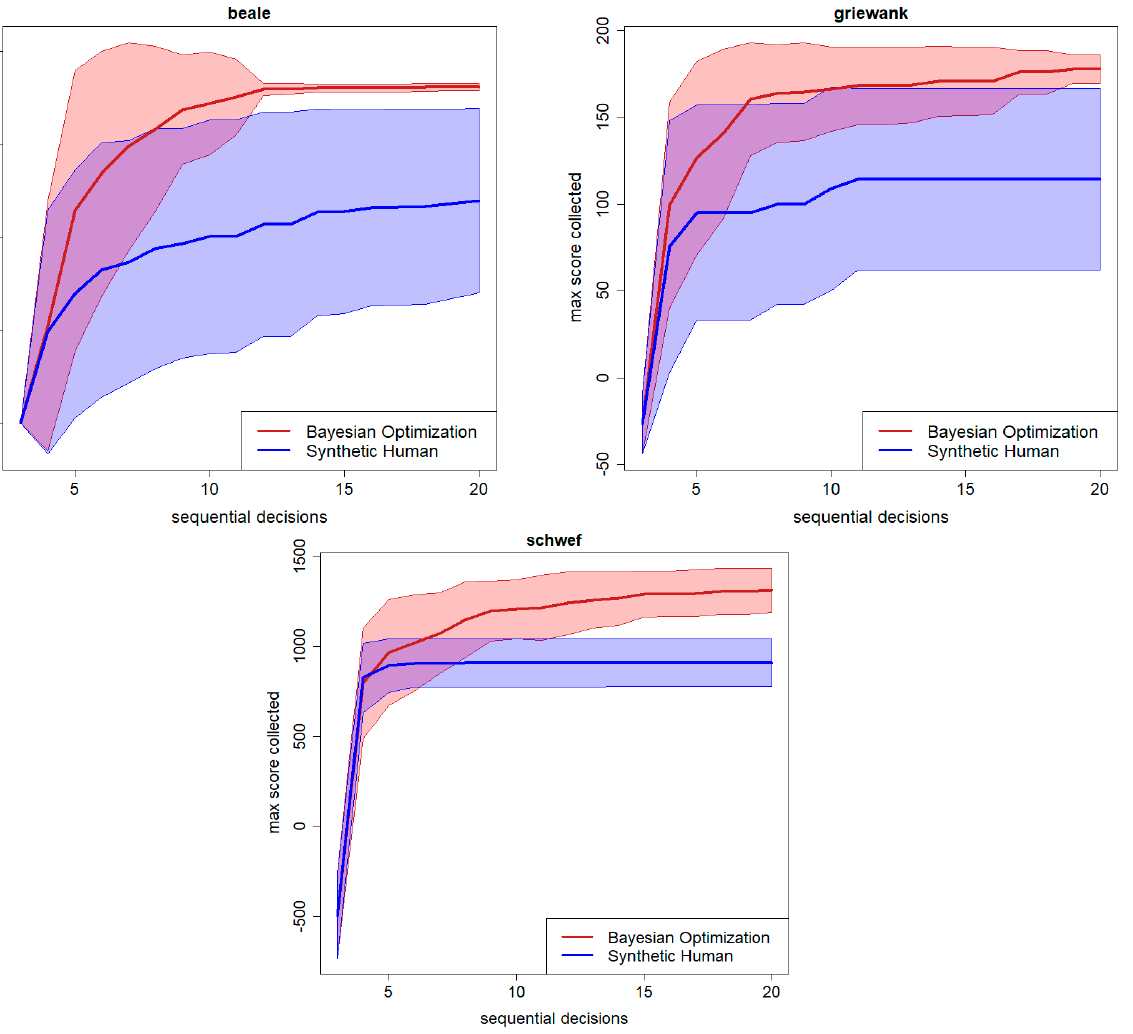
Figure 6. Max score observed over sequential decisions: cases with BO outperforming SH.